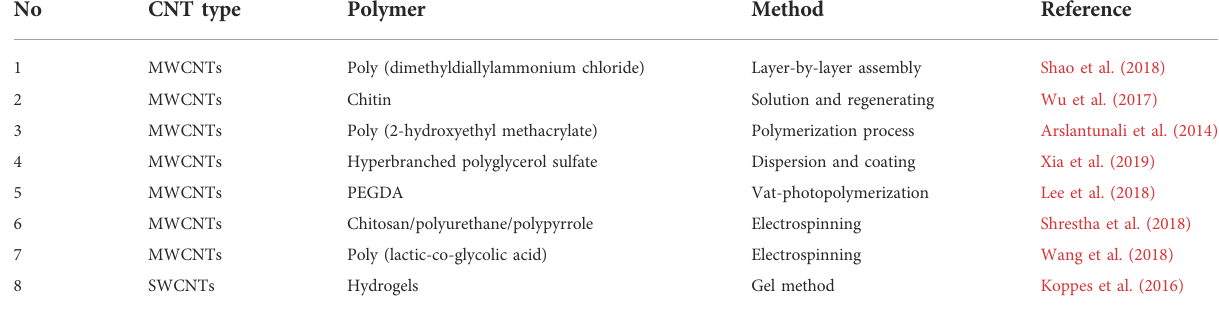
TABLE 1 A list of CNTs with polymers for neural tissue